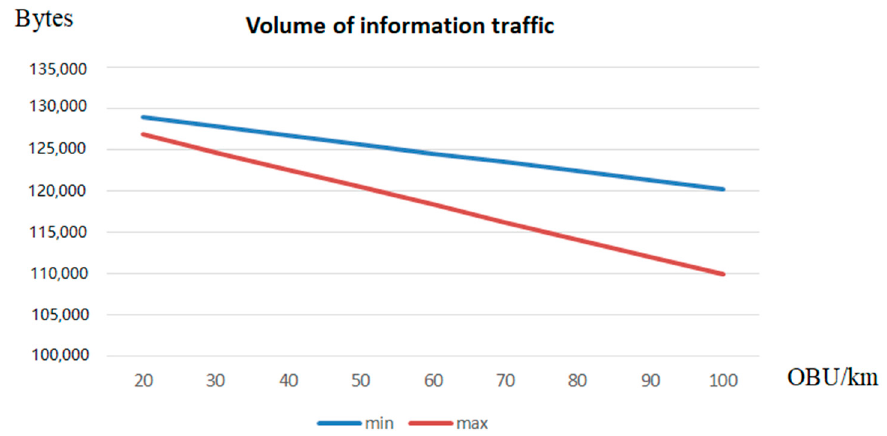
Figure 4. Dependence of the volume of information traffic on road traffic intensity with a 64-bit protocol.